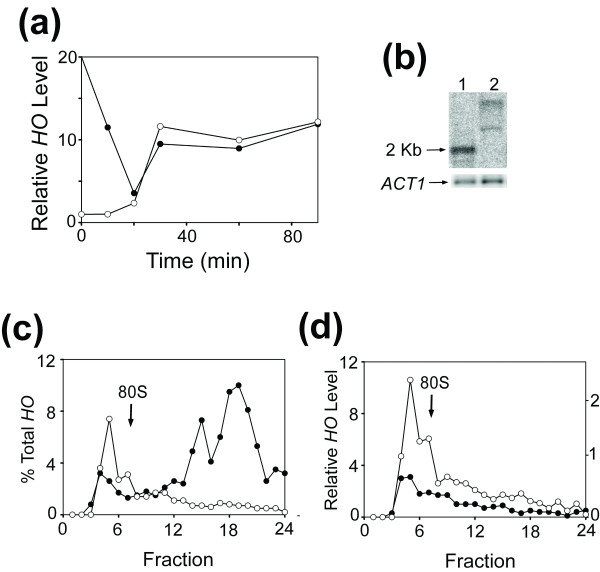
Transcriptional and translational downregulation of HO expression in response to mating pheromone. (a) Relative levels of HO mRNA (normalized to 1.0 for the long transcript at time = 0 min) as a function of time after a-factor treatment. RNA was prepared and analyzed as in Figure 2c. Closed circles show values for both forms of transcripts and open circles represent values for the long HO transcript. (b) Northern analysis of total RNA (10 µg) from growing cells (lane 1) or cells treated with a-factor for 30 minute (lane 2). The blot was stripped and re-probed for ACT1 as a loading control. (c) Relative levels of HO mRNA across polysome gradients in growing cells (filled squares) or cells treated with a-factor for 30 minute (open circles). Gradients were performed and analyzed as described in Figure 2 using PCR primers recognizing both HO transcripts. The top of the gradient is to the left and the position of the 80S monosome is marked with the arrow. (d) Relative levels of the long forms of HO across polysome gradients in growing cells (filled circles, right axis) or cells treated with a-factor (open circles, left axis). QPCR using primers specific to the long forms of HO was performed on cDNA obtained from the same RNA samples used in the experiment described in panel c of this figure. Note the difference in scale on the two axes.